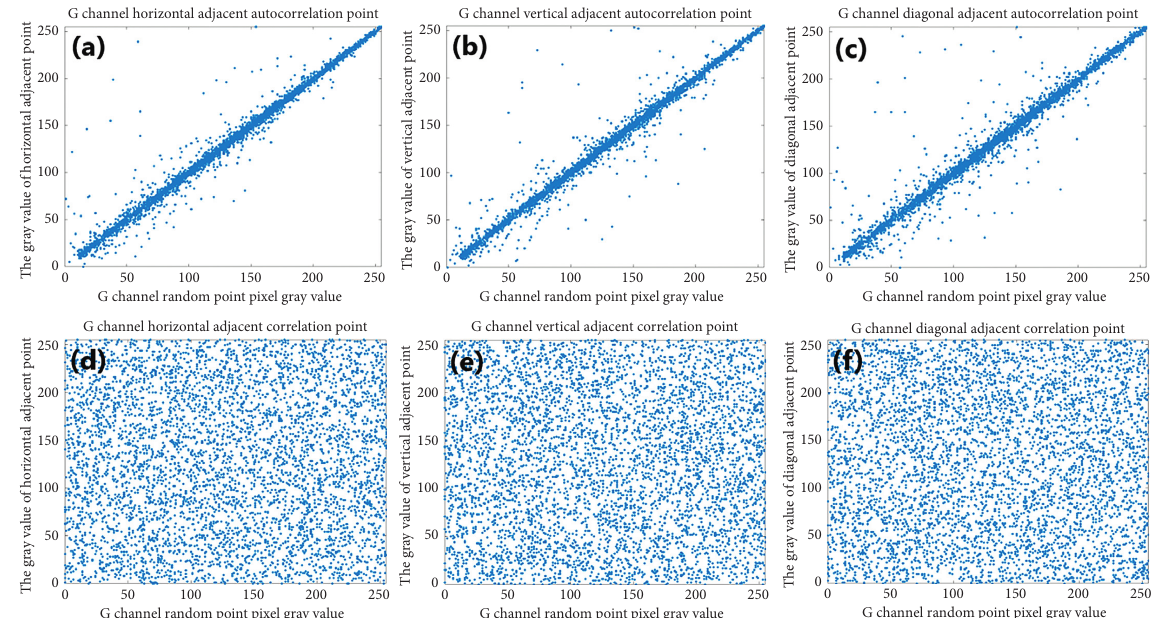
Figure 11: Correlation and autocorrelation of B channel adjacent pixels of the pepper image and its ciphered image: (a) horizontal direction of the pepper image; (b) vertical direction of the pepper image; (c) diagonal direction of the pepper image; (d) horizontal direction of the pepper ciphered image; (e) vertical direction of the pepper ciphered image; (f) diagonal direction of the pepper ciphered